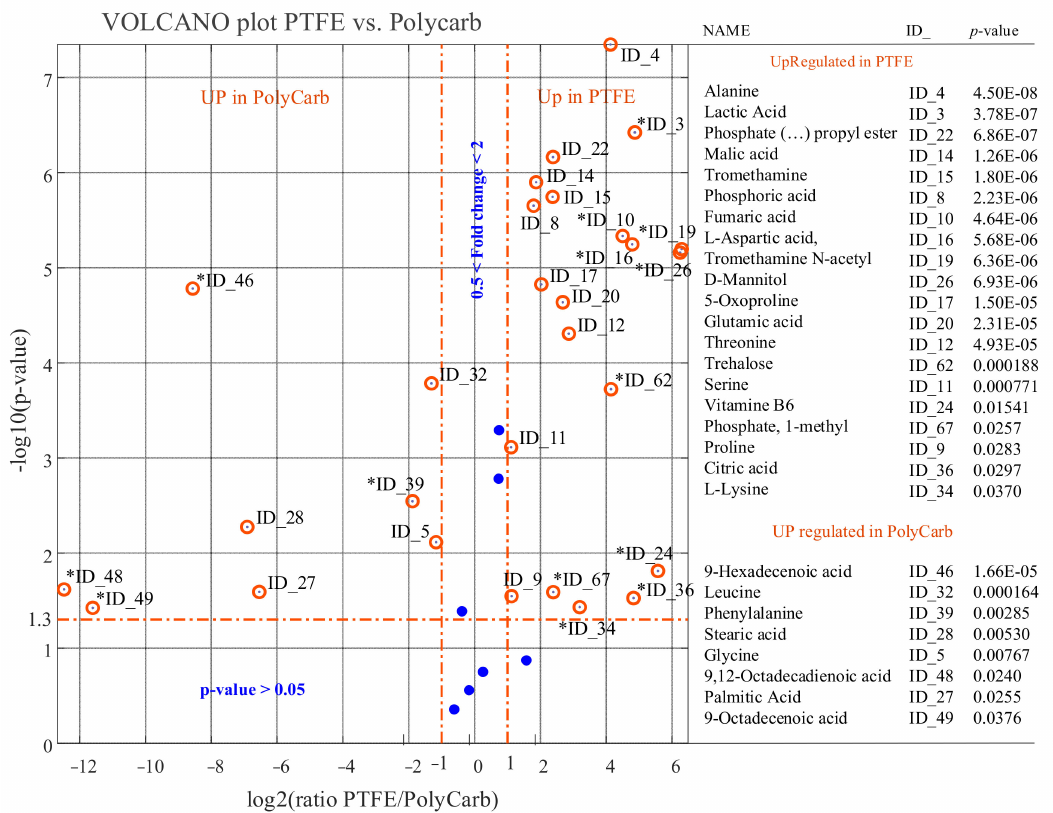
Figure 8. Results of univariate comparison of Teflon (PTFE class) vs. polycarbonate (PolyCarb class). For each metabolite, fold change (FC) is defined as the ratio between mean relative abundances in PTFE and PolyCarb classes. Only metabolites with p value < 0.05 and fold changes greater than 2 are considered upregulated in the PTFE class, and only metabolites with p value < 0.05 and fold changes lower than 0.5 are considered upregulated in PolyCarb class (orange rings). Blue dots represent metabolites with no significantly different levels in the two compared classes. Fold change of metabolites marked with an asterisk (*) has been evaluated by the data imputation strategy described in the text. Metabolites can be tracked back to identified metabolites in Table 1 through the ID_##